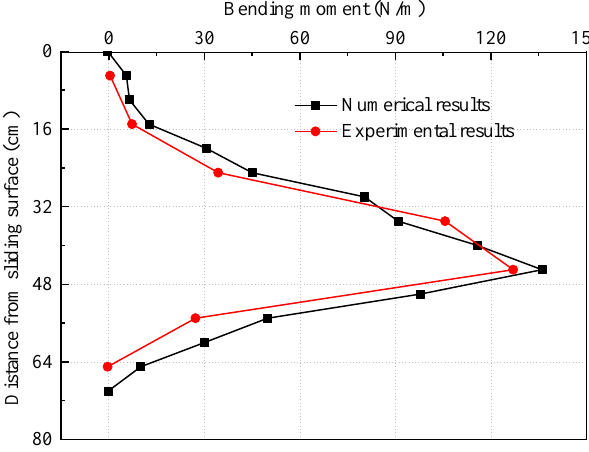
Figure 15. The bending moment distribution of the mid stabilizing pile.